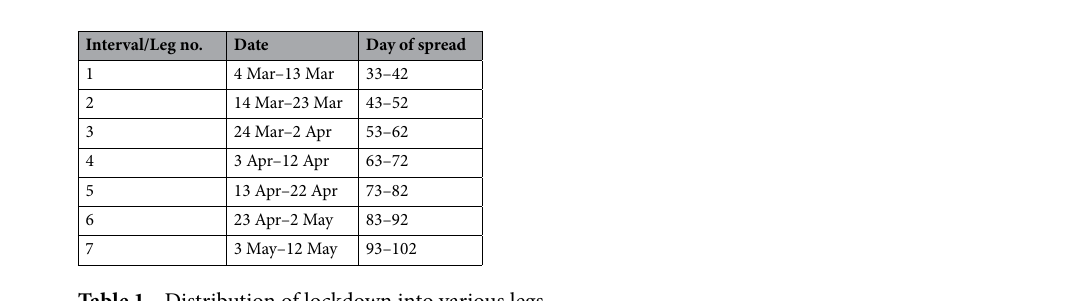
Table 1. Distribution of lockdown into various